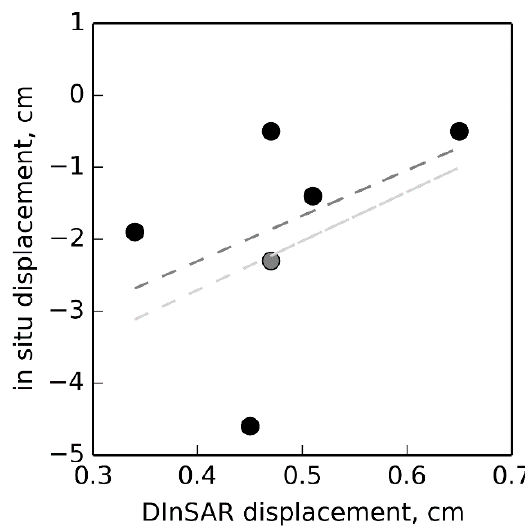
Figure 7. Comparison of in situ and DInSAR-derived summer displacement. Note two different in situ values for one DInSAR value (black and grey circles). Two linear fits are shown separately for each of two in situ measurements, which are in one DInSAR pixel.